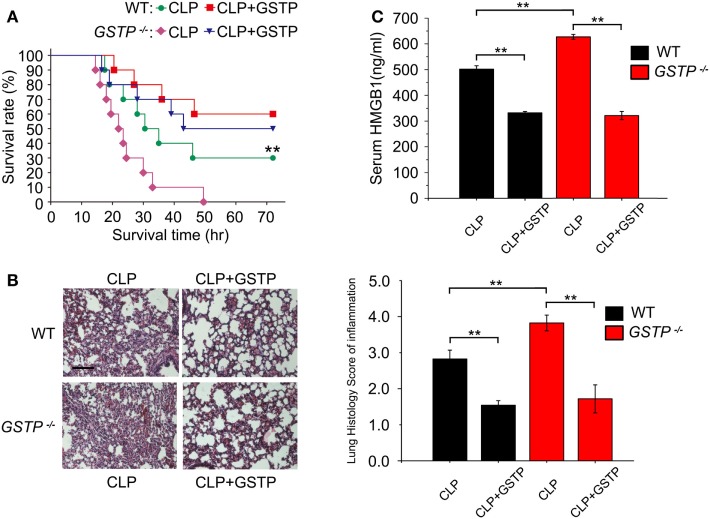
Glutathione S-transferase Pi (GSTP) improves survival and reduces serum high mobility group box-1 protein (HMGB1) level in septic mice. (A)
Gstp−/− and wild type C57BL/6 mice were treated with 2 mg/kg of GSTP or lypopolysaccharide-free saline, respectively, 30 min after CLP surgery, and survival rate of mice was monitored continuously. (B) Lung tissues of the mice were collected and subjected to Hematoxylin and Eosin staining 10 h after CLP, and examined by light microscopy (magnification, ×100). Scale bar: 100 µm. Histological scoring of lung injury was evaluated based on inflammatory infiltrate in CLP mice. (C) Detection of mouse serum HMGB1 level by ELISA. Mouse blood was collected from retroorbital sinuses of mice. Serum HMGB1 level was measured by ELISA 12 h after CLP surgery. Data information: in (A), Kaplan–Meier analysis was used to analyze the survival rates of CLP mice. n = 10 mice/group. **P<0.01 versus Gstp−/− CLP group by the log-rank test for between-group comparisons. In (B,C), Graphs show mean ± SD. n = 8–10 mice/group. **P<0.01 versus corresponding CLP group by unpaired Student’s t-test. Data shown were representative of three independent experiments.